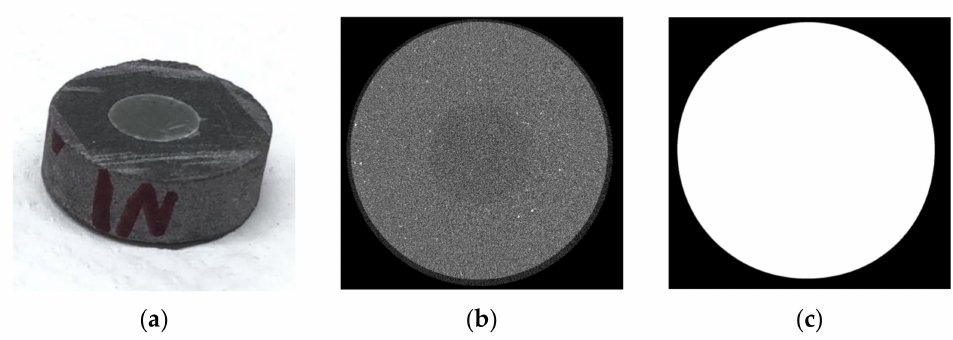
Figure 1. Flowchart of the methodology.